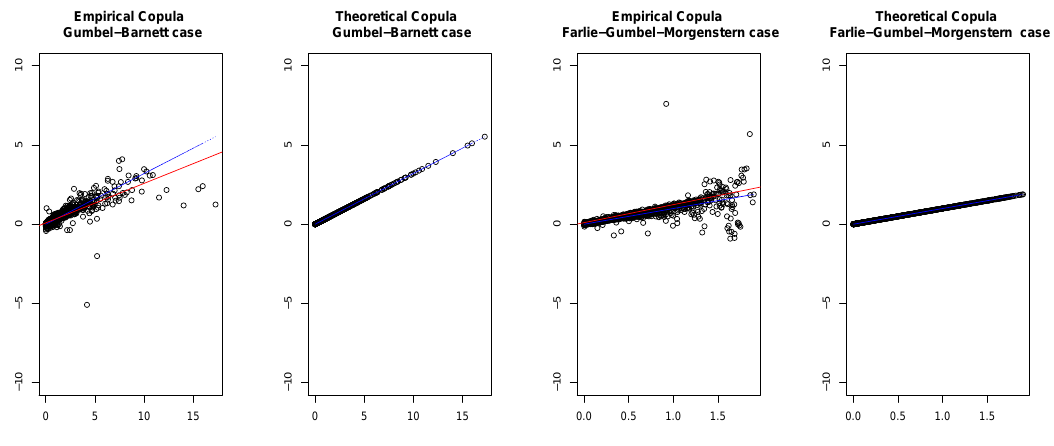
Figure 2: Illustration for theoretical and estimated linear expression in σ 13 in Equation (20) . We draw two types of set of points: { α i j ( u ), (cid:98) β i j ( u ) } (see first and third panels from the left), and { α i j ( u ), β i j ( u ) } (see second and fourth panels). First and second panels: Gumbel-Barnett case with σ 13 = 0.32 . Third and fourth panels: Farlie–Gumbel–Morgenstern case with σ 13 = 0.99 . We present the theoretical regression line (blue line) and the estimated one (red